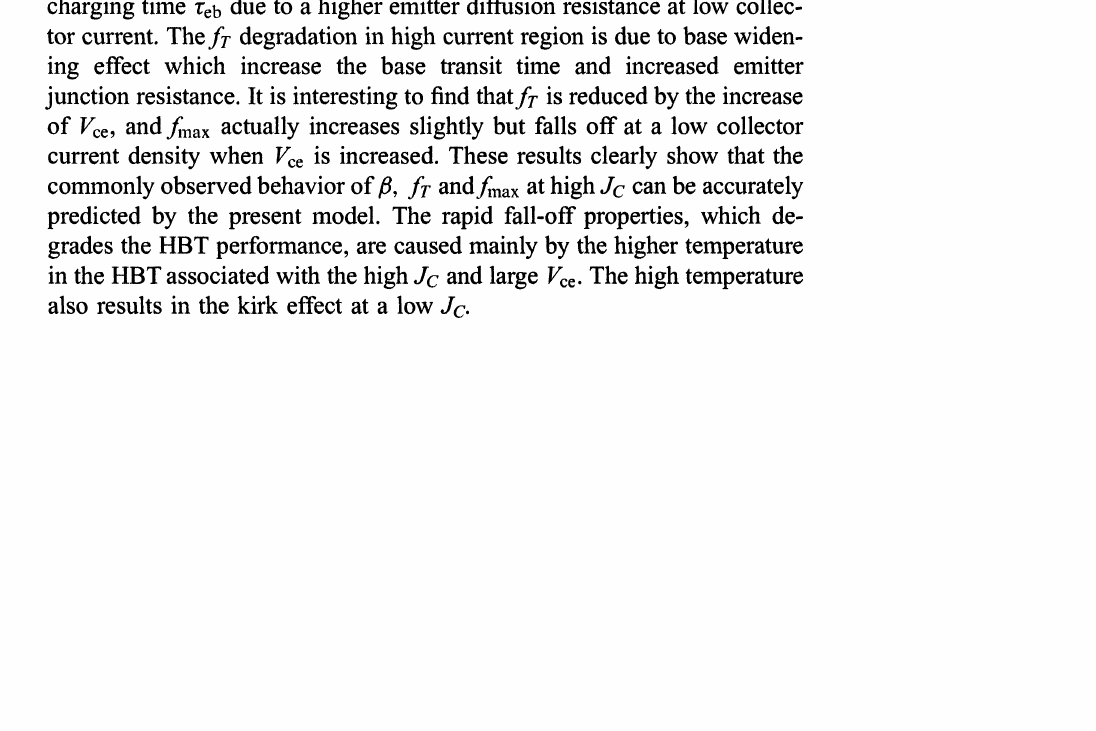
FIGURE 10 Calculated current gain versus collector current density with Vce voltages as parameters for SI substrate thickness of 200